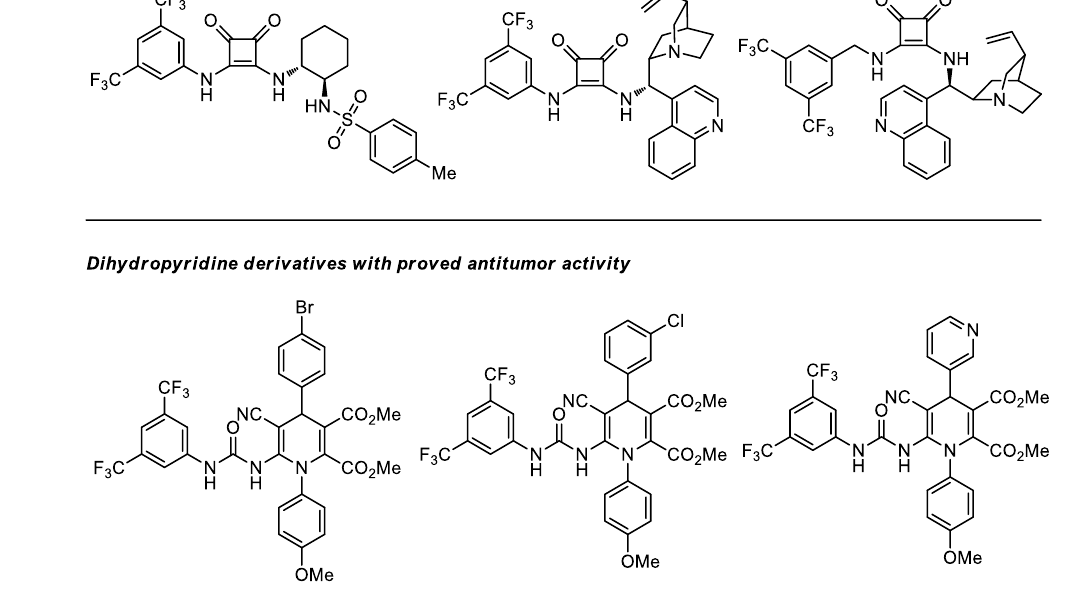
Figure 4. Antitumor squaramides and 1,4-dihydropyriridines synthesized by our group.